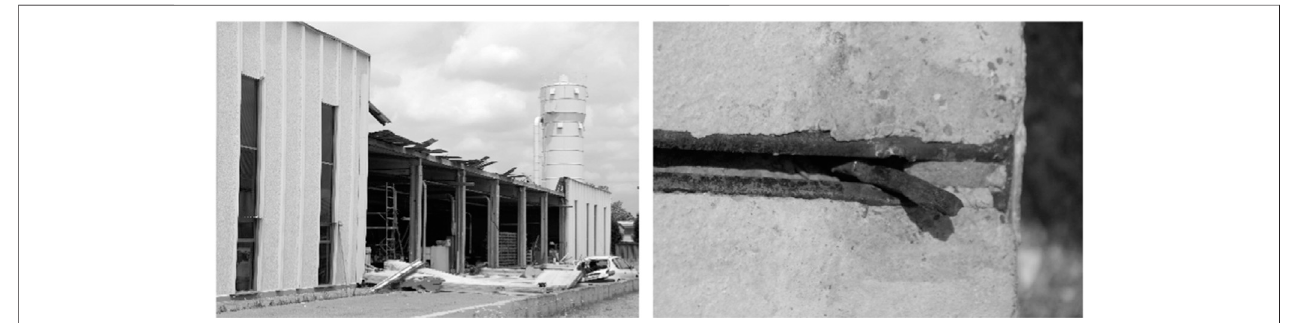
FIGURE 5| (left) Collapse of concrete cladding panels, and (right) failure ofa typical cladding-to-structure connectionduring the Emilia earthquakes [adopted from Zoubek et al. (2016a)].